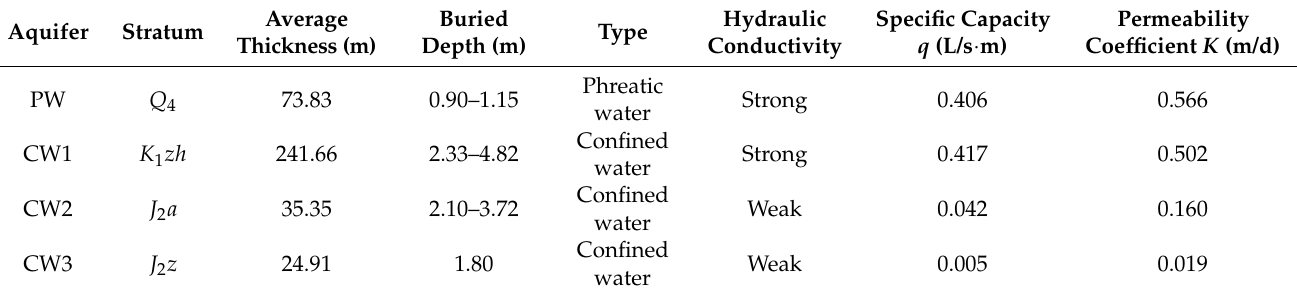
Table 1. Main information about the aquifer in the Yingpanhao coal mine.